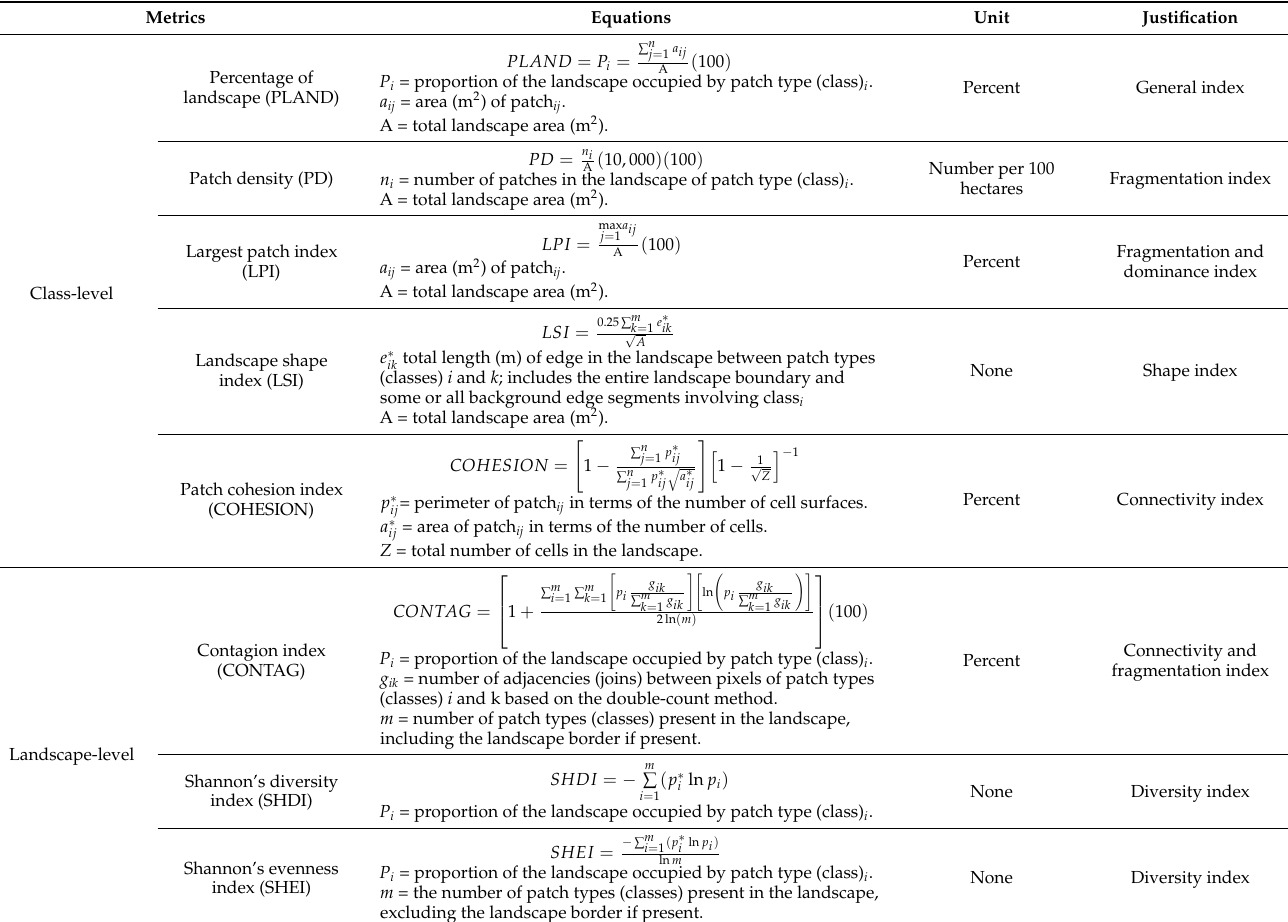
Table 2. Landscape metrics used in this study